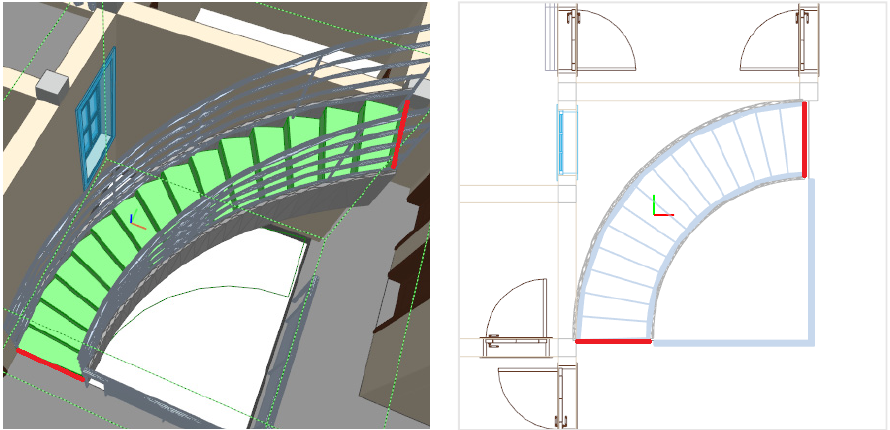
Figure 5. Illustration of the intersection lines between the slabs and the spiral stair.